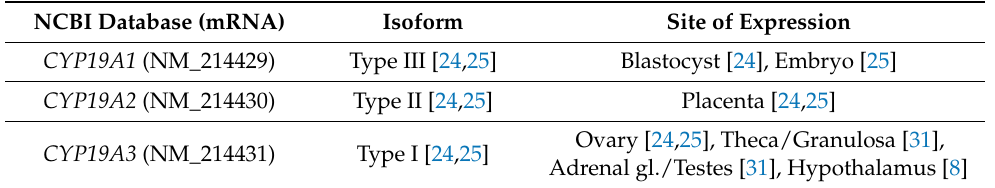
Table 1. Porcine CYP19 copies and sites of expression.